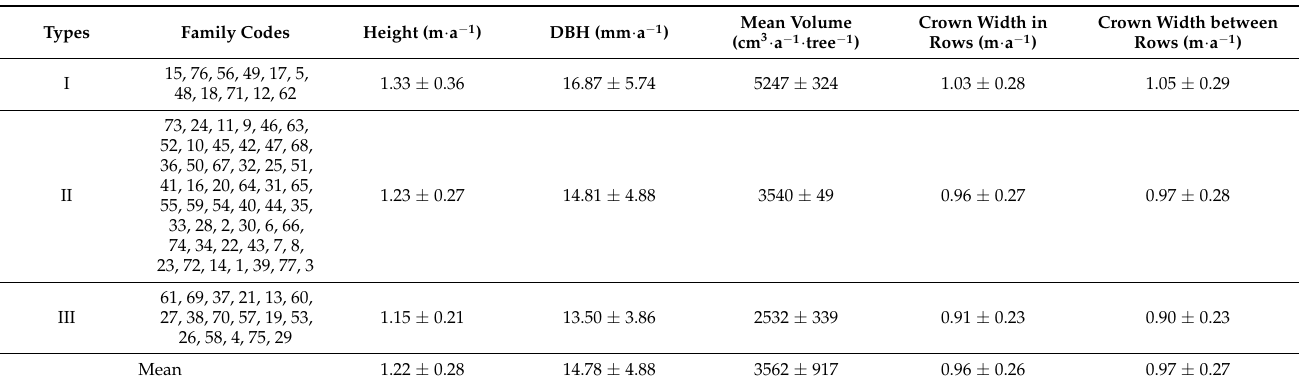
Table 4. Classification of C. axillaris families based on growth